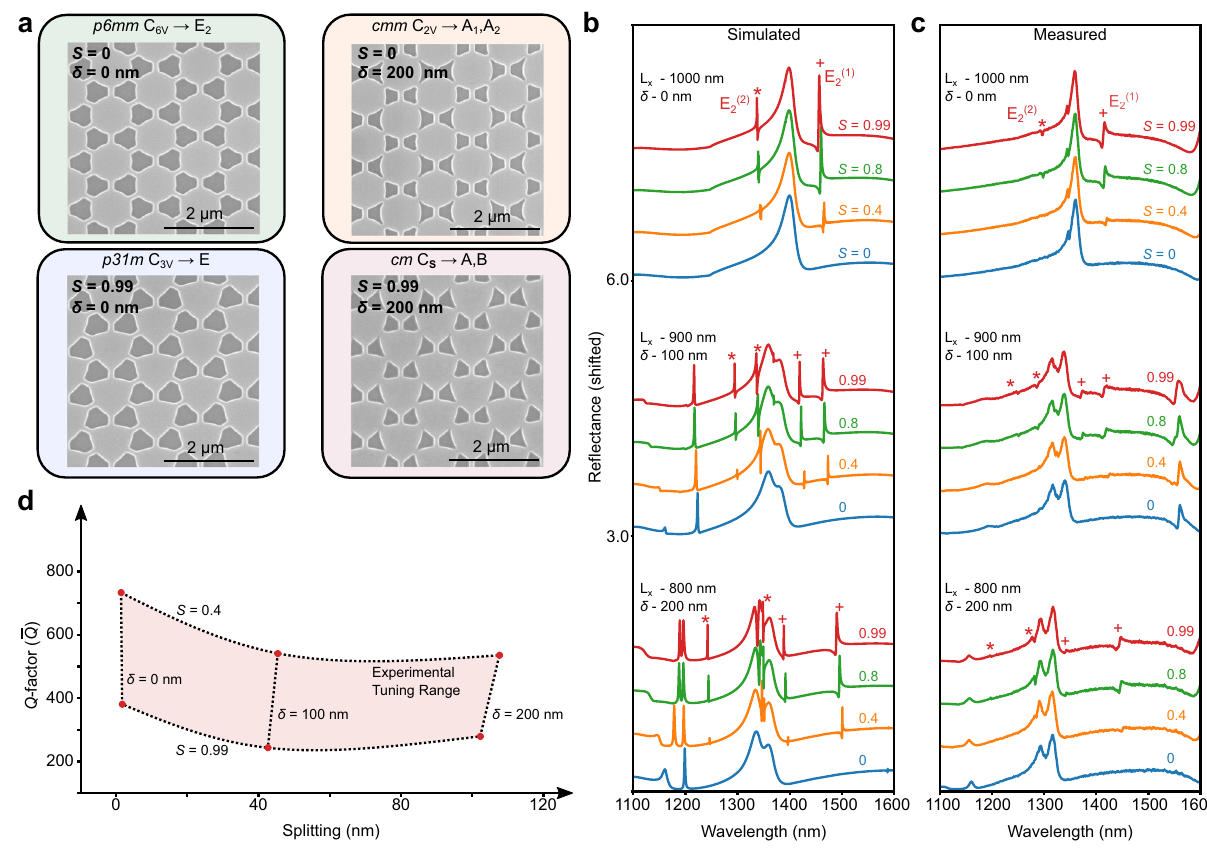
Fig. 4 | Resonator and lattice deformations to engineer splitting and Q -factor. a Scanning electron micrographs of fabricated silicon metasurfaces with designs for the four regimes of resonator deformation into a triangle and/or lattice con- traction. Simulations ( b ) and measurements ( c ) of unpolarized re fl ectance for resonator and lattice deformations of the silicon metasurface. When no lattice deformationispresent( δ =0nm)andtheresonatorsarecylinders( S =0)nomodes are visible. If the resonators are deformed into triangles two peaks appear from